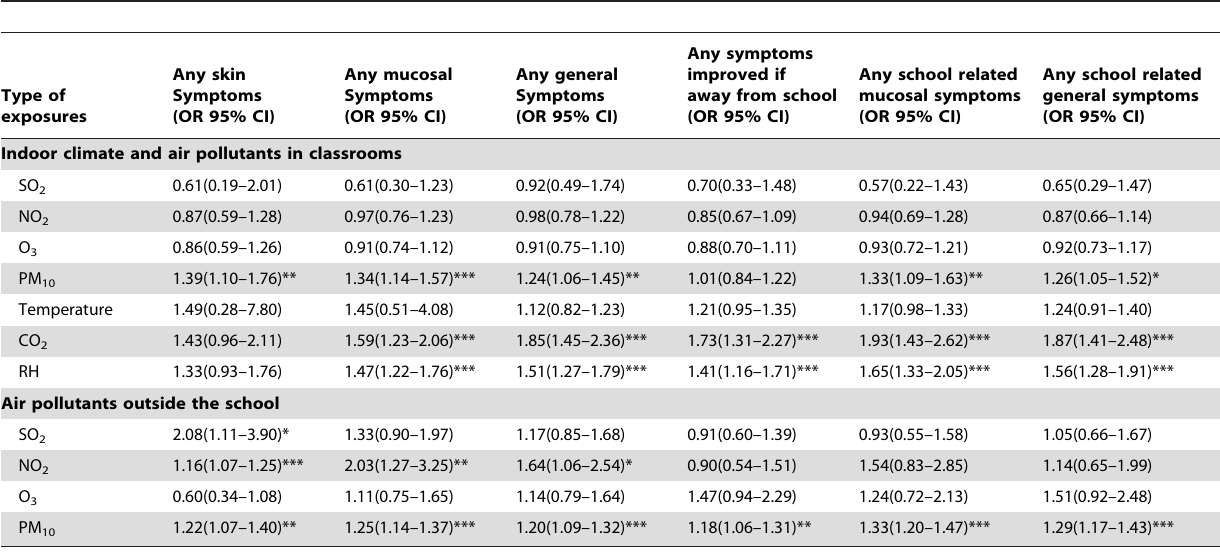
Odds ratio (OR) with 95% confidence interval (CI) calculated by multiple logistic regression. Adjustment for age, gender and parental asthma or allergy, analysing each exposure variable separately. *P , 0.05. **P , 0.01.